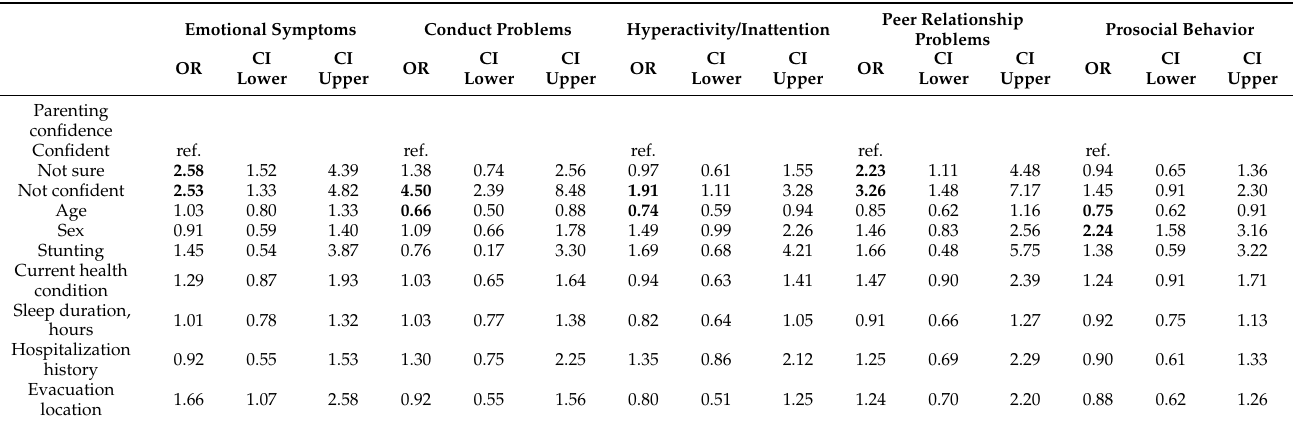
Table 3. Odds ratio of multiple logistic regression analyses for the high-risk group of SDQ subscales ( n =